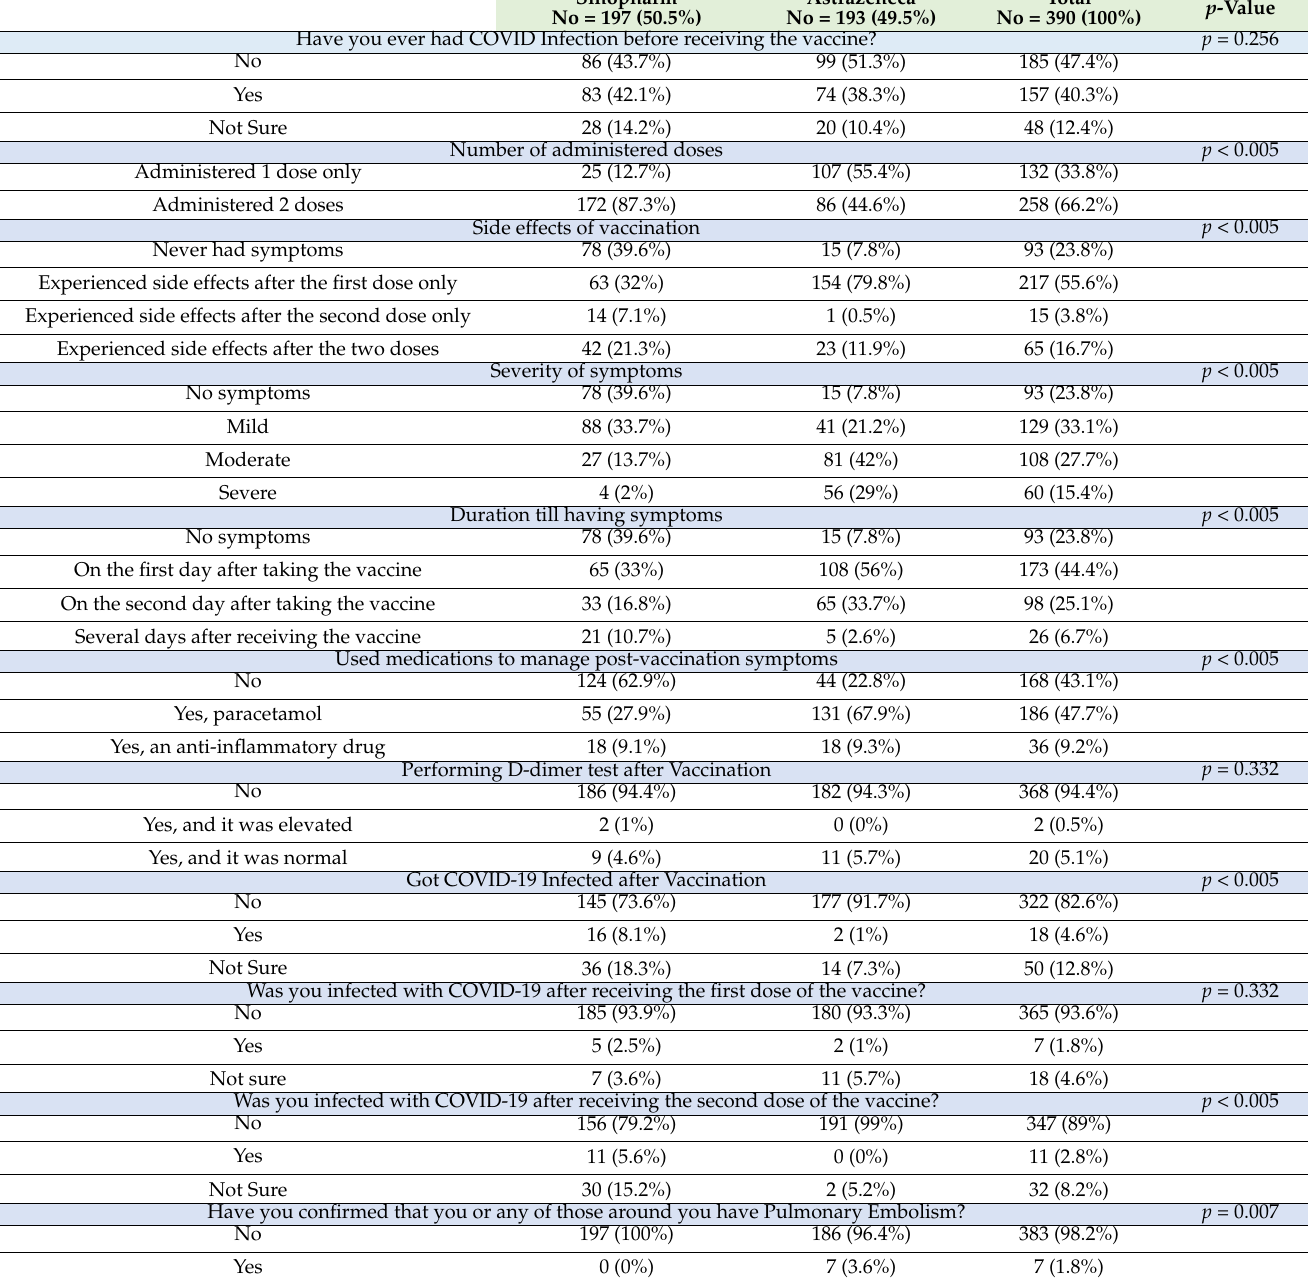
Table 3. Comparison between Sinopharm and Astrazeneca vaccination information, side effects presence, severity, and COVID-19 infection after